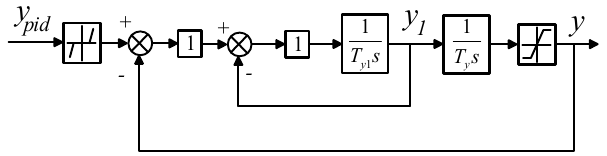
Figure 2. Schematic diagram of pump turbine regulating system.